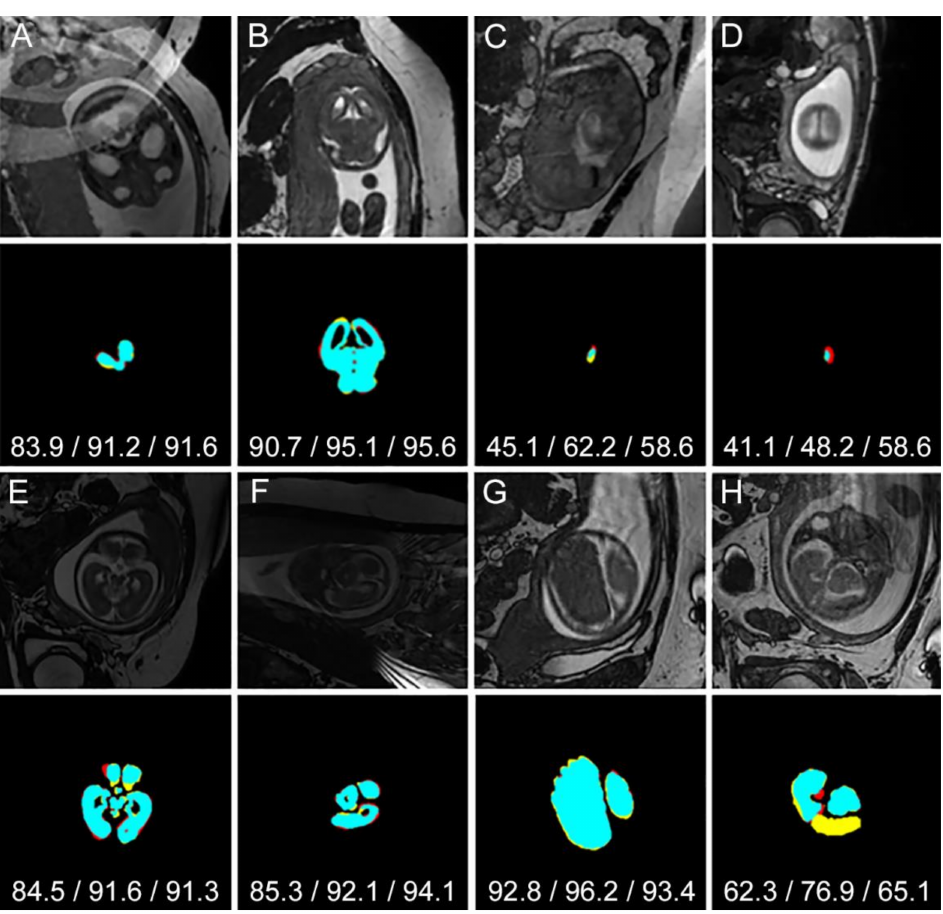
Figure 7. Examples of P AVG segmentation results for challenging cases ( A – D ) and for abnormal cases; mild ventriculomegaly ( E ), agenesis of corpus callosum ( F ) and structurally deformed ( G , H ). Black, cyan, red and yellow represent TN , TP , FP and FN , respectively. Jaccard/Dice/Sensitivity scores are shown under each